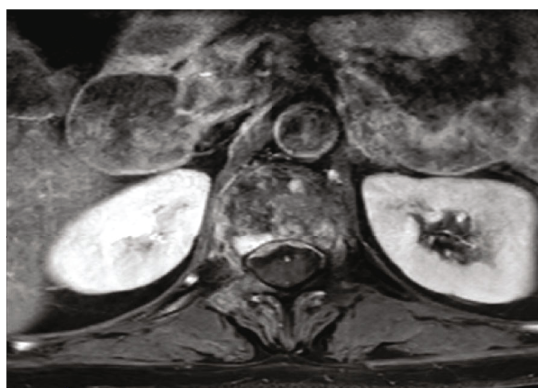
Figure 3: Axial section of an MRI in weighted sequence T1 with gadolinium injection showing irregular contrast uptake of epidural space with heterogeneity of the bone structure